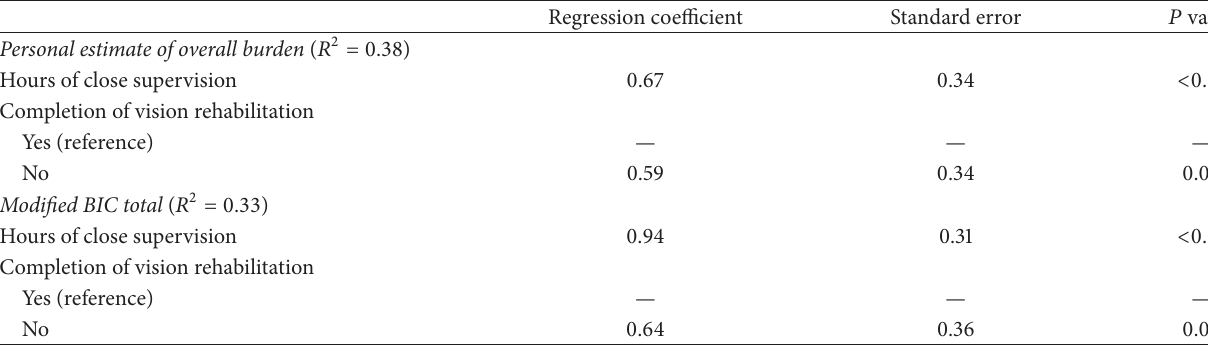
Table 3: Covariates impacting caregiver burden (2 linear regression